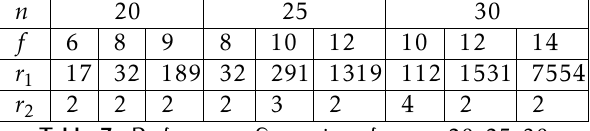
Table 7. Performance Comparison for n = 20 , 25 ,